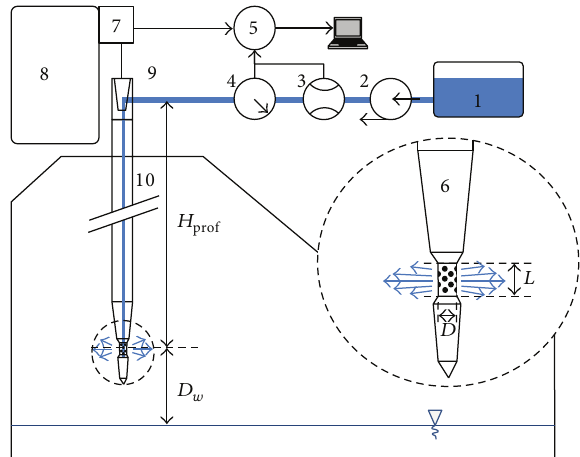
Figure 9: Scheme of the Perm´eafor test procedure. 1: water tank, 2: pump, 3: flow meter, 4: pressure sensor, 5: data logger, 6: patented Perm´eafor tip, 7: displacement transducer, 8: geotechnical drill device, 9: casing connector, and 10: conventional casing. 𝐷 is the diameter of the screened tip (50mm) and 𝐿 is its length (50mm).